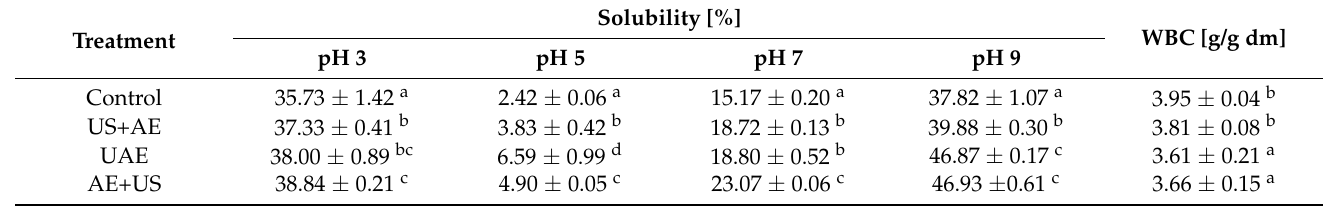
Table 3. Solubility and water binding capacity (WBC in g per g dry matter) of extracted pumpkin seed